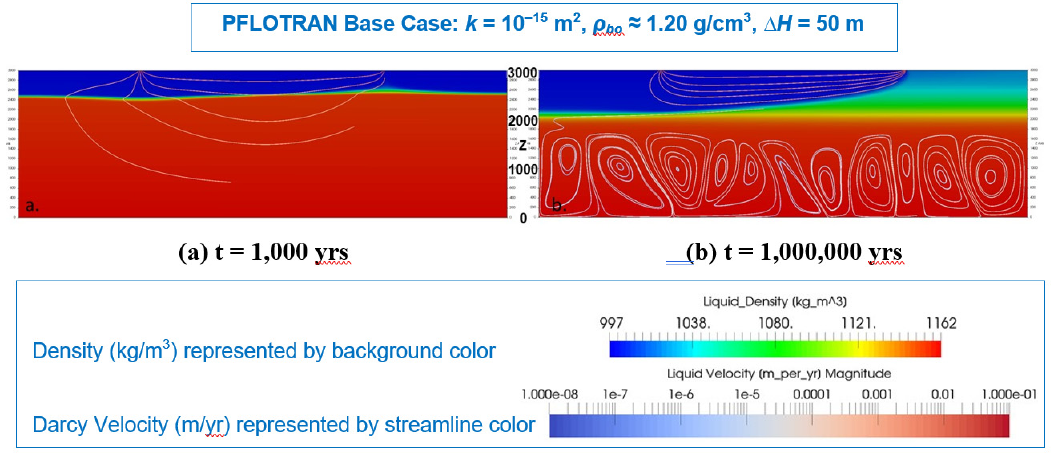
Figure 4. PFLOTRAN Base Case (k = 10 − 15 m 2 ) Model Results (Fluid Density and Darcy Flux) ( a ) at 1,000 years and ( b ) 1,000,000 years.